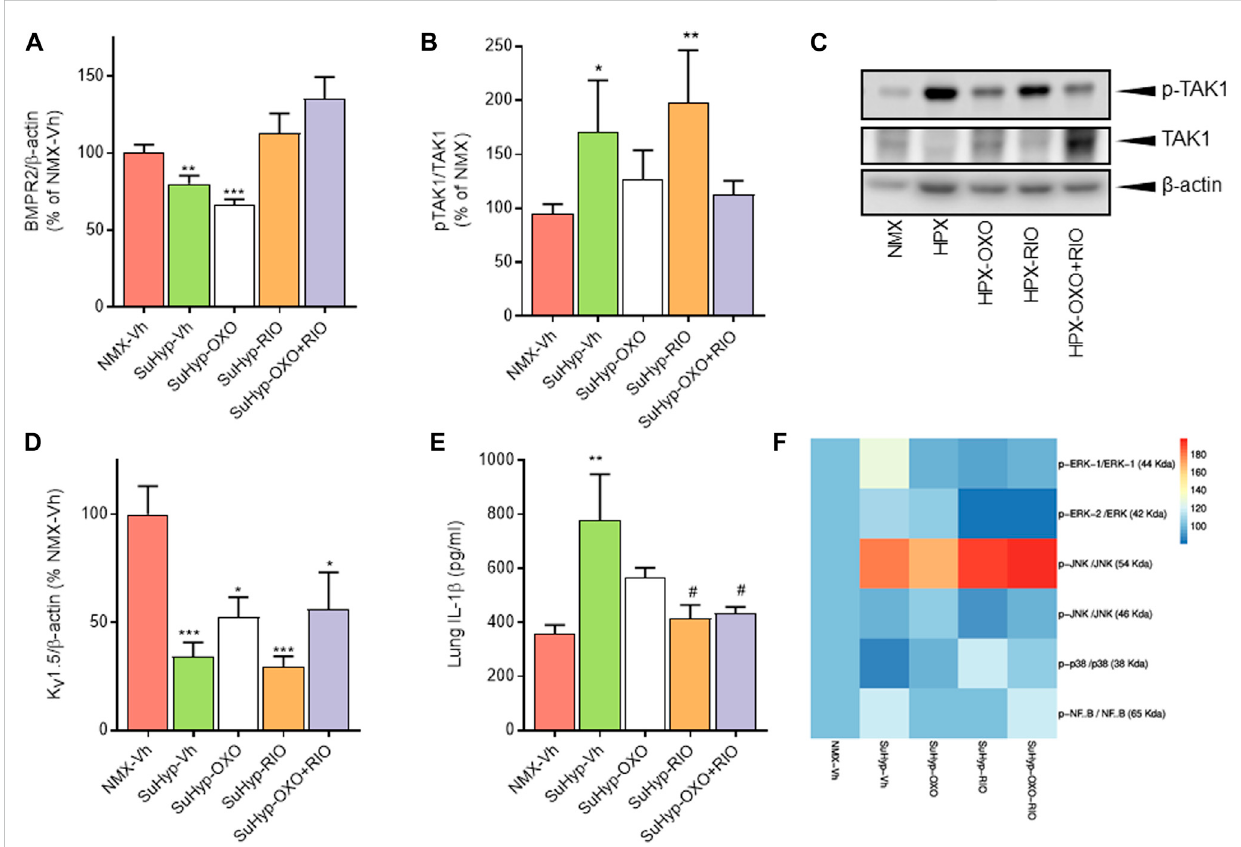
FIGURE 7 Treatment with riociguat and 5-z-7oxozeaenol restores the expression of BMPR2 and inhibits IL- β in the lungs from SuHyp rats. Densitometry analysis of (A) BMPR2/ β -actin and (B) pTAK1/TAK1 protein expression in lung homogenates from control (normoxic) rats and rats with PAH (SuHyp) treatedwithvehicle(Vh),5-z-7-oxozeaenol(OXO),riociguat(RIO)oracombinationofbothdrugs(OXO+RIO). (C) RepresentativeimageofWesternblot showing p-TAK1, TAK1 and β -actin. (D) Densitometry analysis of Kv1.5/ β -actin in lung homogenates. (E) Quanti fi cation of IL-1 β levels in lung homogenates in the fi ve experimental groups. (F) Heatmap showing the densitometry analysis of Western blot performed to assess the activation of the NF- κ B and MAPK signaling pathway. N = 6-10 animals in each group, * p < 0.05 versus normoxia and # vs. SuHyp + vehicle (One sample t